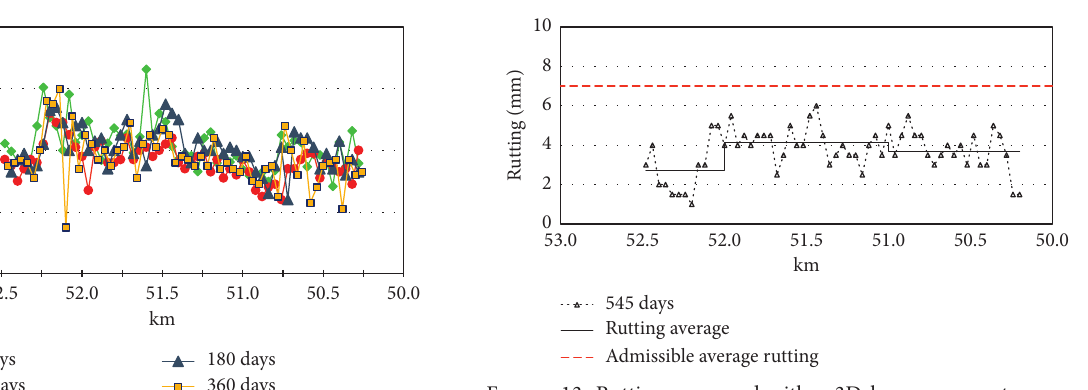
Figure 13: Rutting measured with a 3D laser pavement scanner after 545days of the construction.